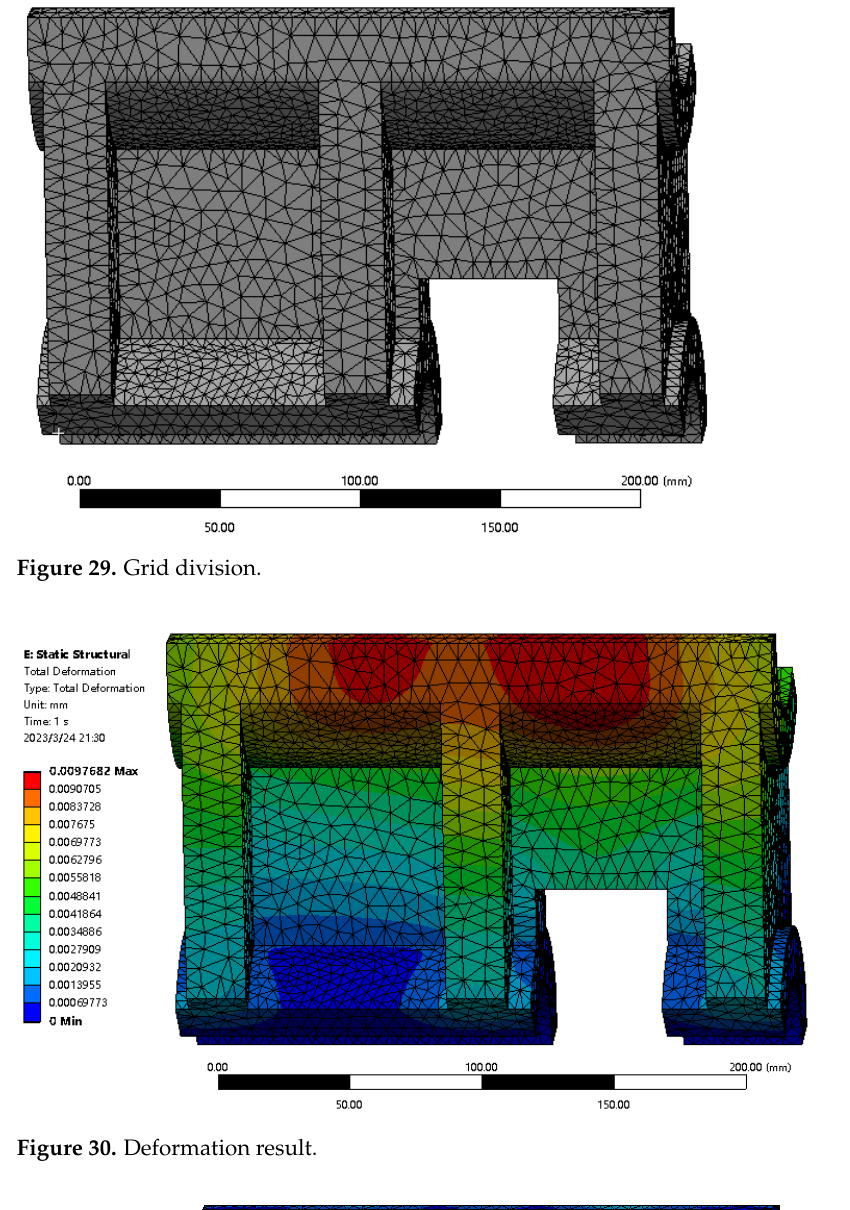
Figure 28. Model after optimization.